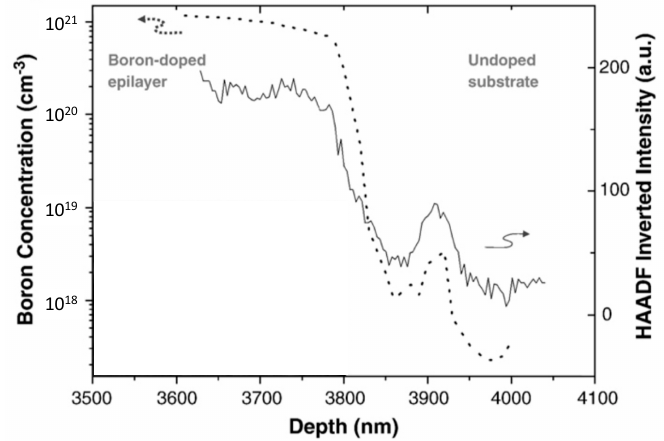
Figure 5. A comparison between HAADF and SIMS is shown for B determination in a boron-doped diamond homoepitaxial layer. The dashed curve corresponds to the SIMS profile and the continuous line to the inverted HAADF profile. Boron can be clearly detected in the 10 20 cm − 3 range. Adapted with permission from Araujo et al. [104] Copyright 2021 ©Elsevier.